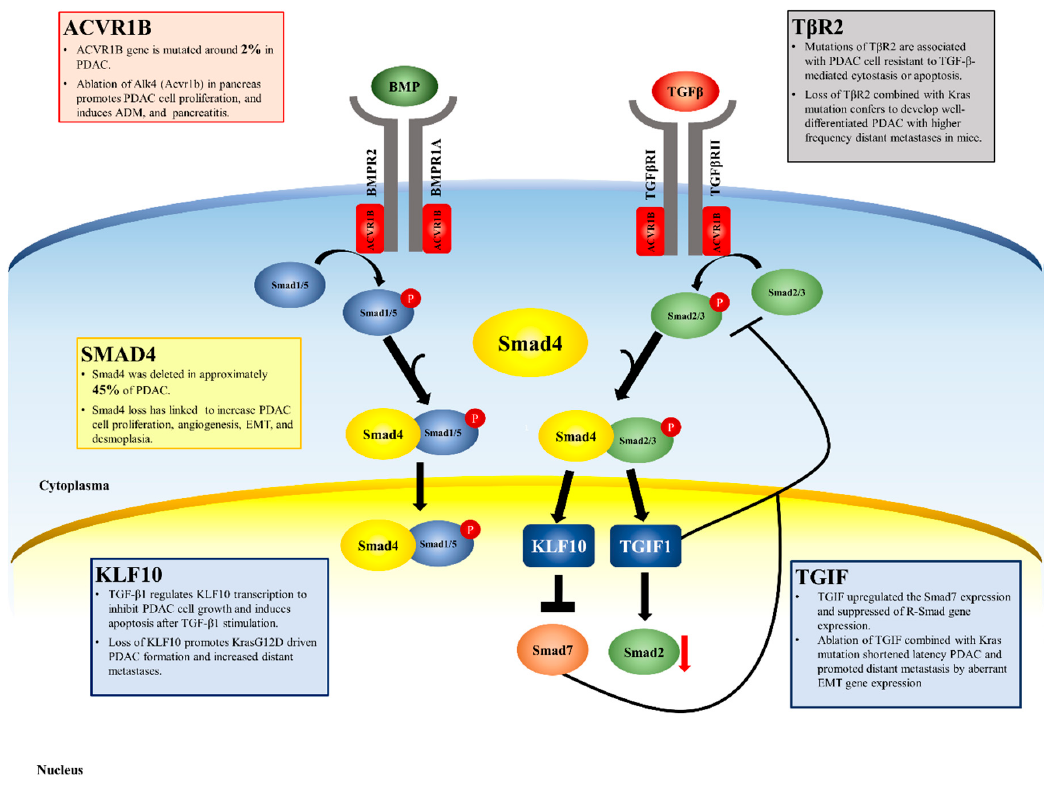
Figure 3. The impacts of mutations in the TGF β signaling transduction components contribute to PDAC development. Overview of the dysregulation TGF- β / BMP signaling pathways in PDAC. In canonical TGF β / Smad pathway, the receptor complexes of TGF β RI and TGF β RII are phosphorylated upon TGF- β binding and then activate Smad2 / 3 (R-Smad). Those activated R-Smads form a complex with the Co-Smad Smad4 and this complex is imported into the nucleus where in association with other transcription factors to regulate transcription of TGF β target genes. The TGF β / BMP pathways’ components that are mutated, deleted, or downregulated, are listed and described in the boxes.